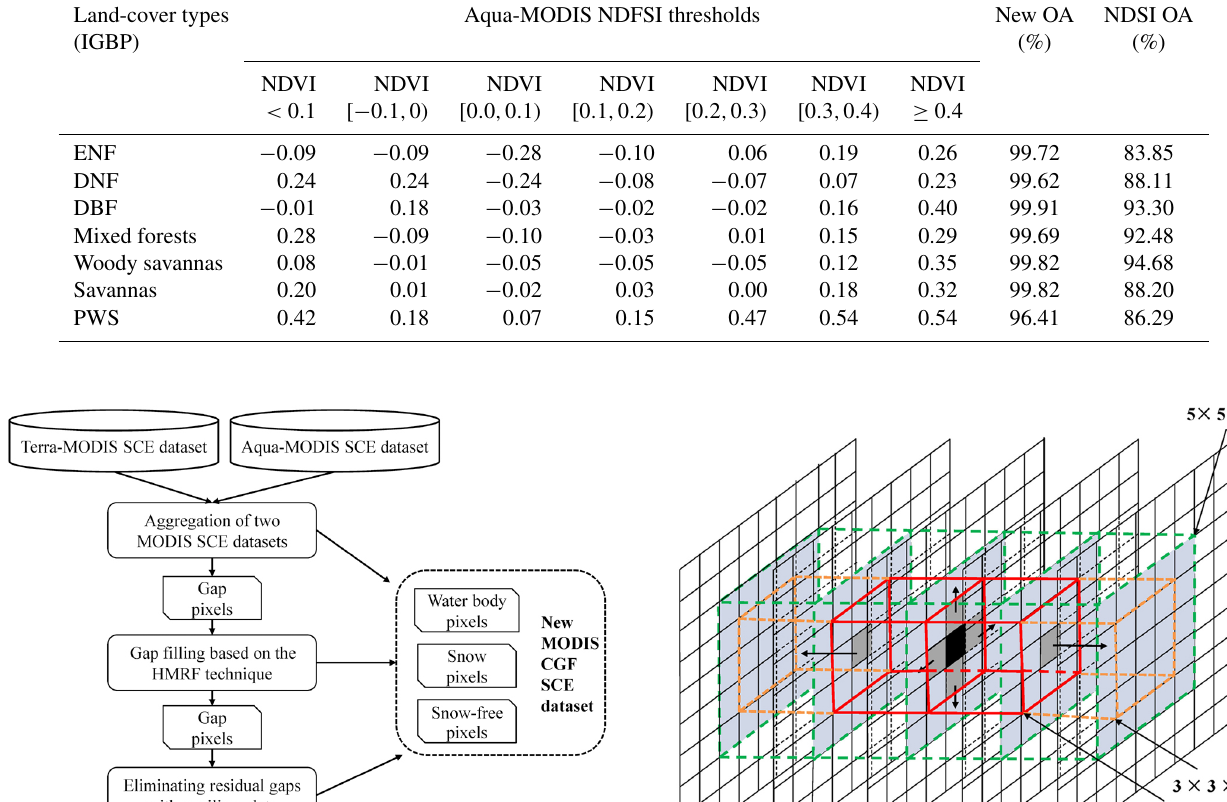
Table 3. Optimized Aqua-MODIS NDVI-NDFSI decision rules for forest land-cover types. Land-cover types